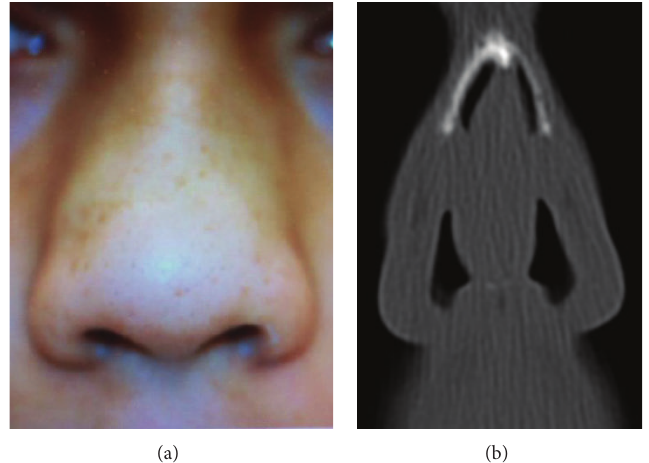
Figure 1: (a) Frontal view of the external nose. Note the swelling of the lateral walls. (b) A CT scan of the anterior nose. Note the wide nasal septum touching the swellings of the lateral pseudotumors which together cause a bulging of the lateral walls.